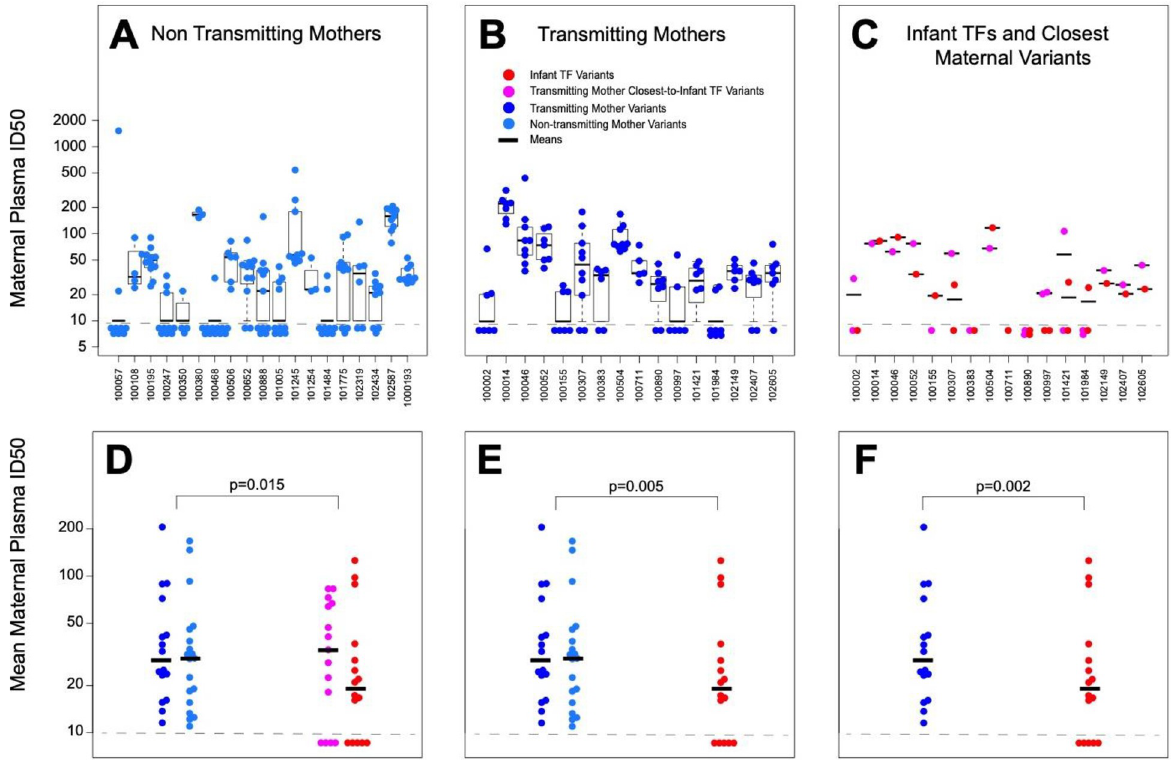
Fig 3. Similar neutralization sensitivity of non-transmitted maternal variants from transmitting and non-transmitting mothers to paired maternal plasma, while infant T/F variants are more resistant to paired plasma than all maternal variants. Maternal plasma potency (ID50) against viruses from non-transmitting mothers (A) and transmitting mothers (B) and infant T/Fs (C, red) and their paired closest maternal sequences (C, magenta). Boxes denote interquartile distributions. Bottom panels: geometric mean ID 50 of non-transmitted variants from each non-transmitting mothers (light blue) and transmitting mothers (dark blue) compared to geometric mean of autologous ID50 of infant T/Fs (red) and closest maternal sequences (magenta). In all panels, black bars indicate the mean of the corresponding color-coded data points. P-values were obtained from fitting a random-effect GLM model. Panel D shows the comparison between all non-transmitted variants and infant T/Fs combined together with the closest maternal sequences. Panel E shows the comparison all non-transmitted variants and the infant T/Fs alone. Panel F shows the comparison between the non-transmitted variants from the transmitting mothers and their paired infant